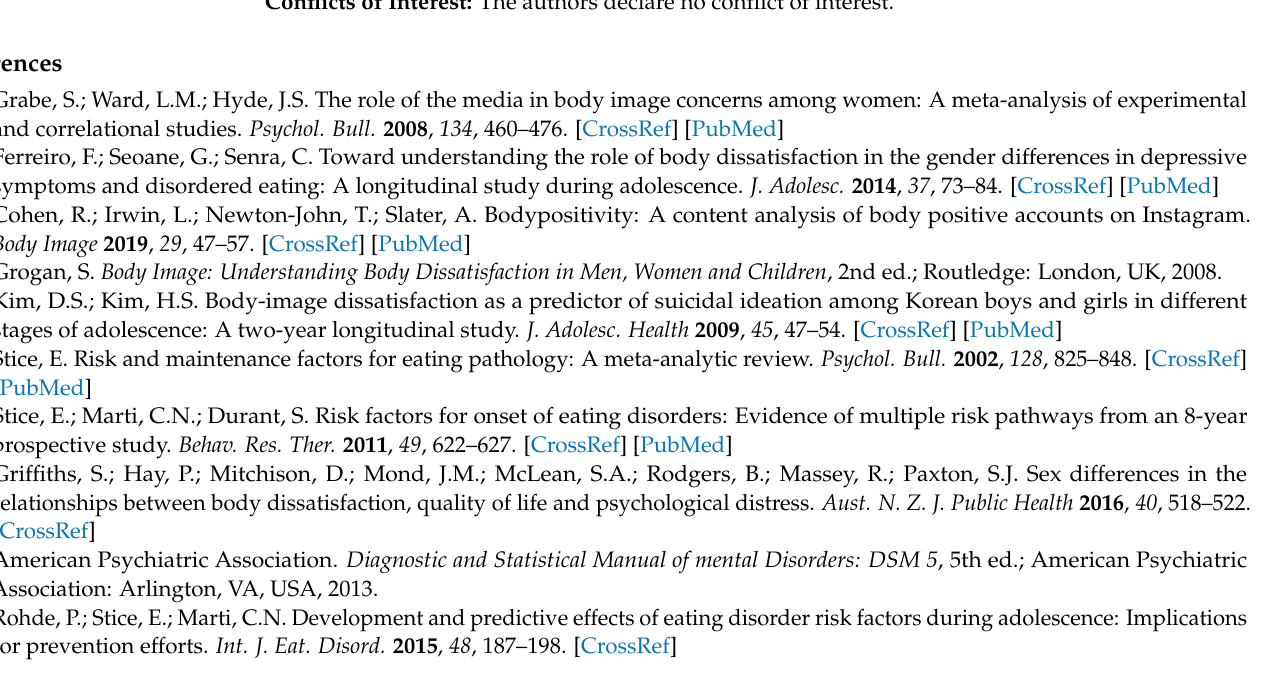
used in the analysis, Table S2: Final Coding Guide with Explanatory Comments, Table S3: Inter-Rater Reliability for Coding Variables, Table S4: Observed Frequencies for Demographic Characteristics and Image Content Variables, Table S5: Distribution of the Fit Ideal by Account Type and Year, Table S6: Distribution of Sexualisation by Account Type and Year, Table S7: Distribution of Objectification by Account Type and